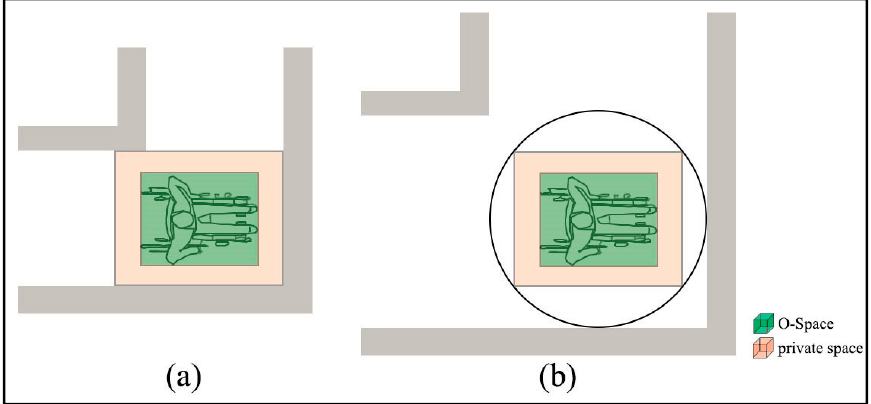
Figure 6. Determination of the buffer distance. ( a ) The width of the gap is the width of the agent’s private space. ( b ) The width of the gap is the diameter of the circumcircle.